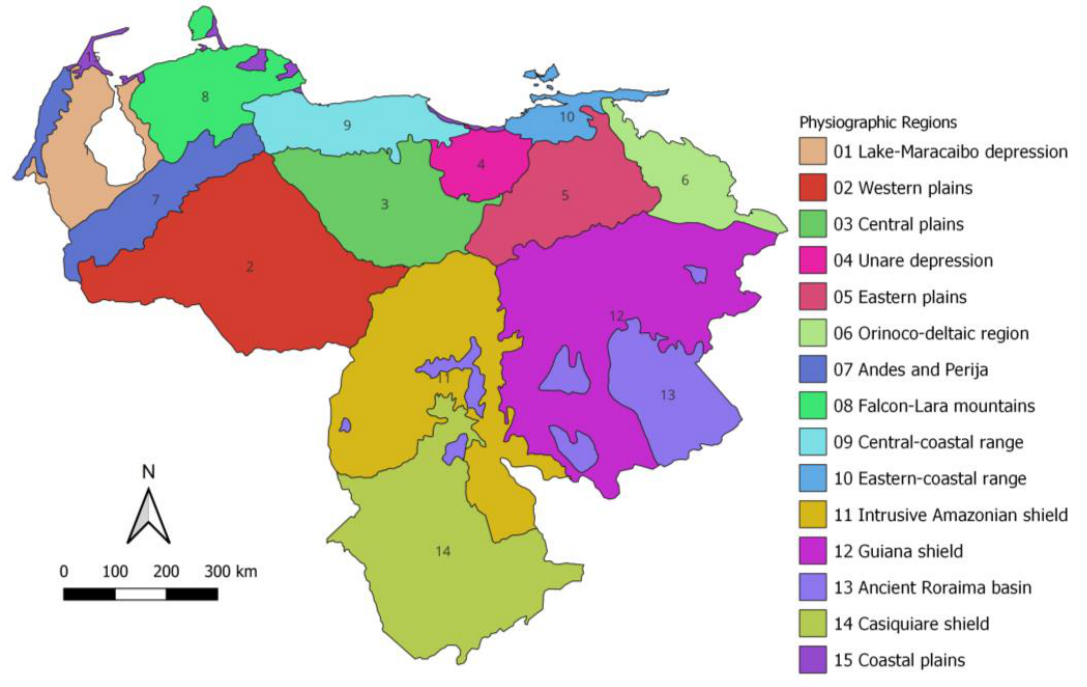
Figure 2. Physiographic regions of Venezuela modified from Elizalde et al. [41].